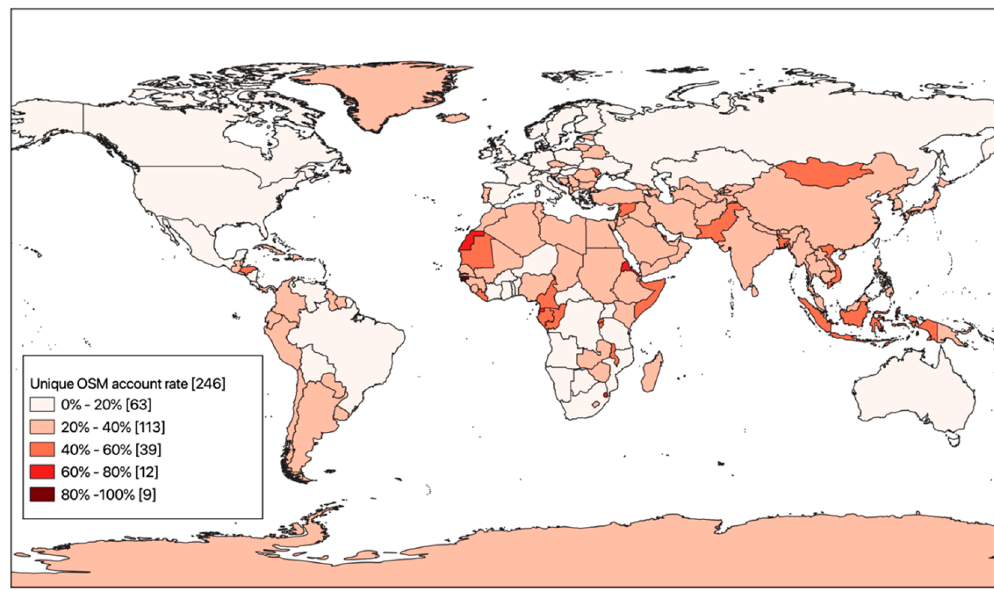
Figure 6 . Distribution rate of OSM Notes posted by unique OSM account by country. Figure 6. Distribution rate of OSM Notes posted by unique OSM account by